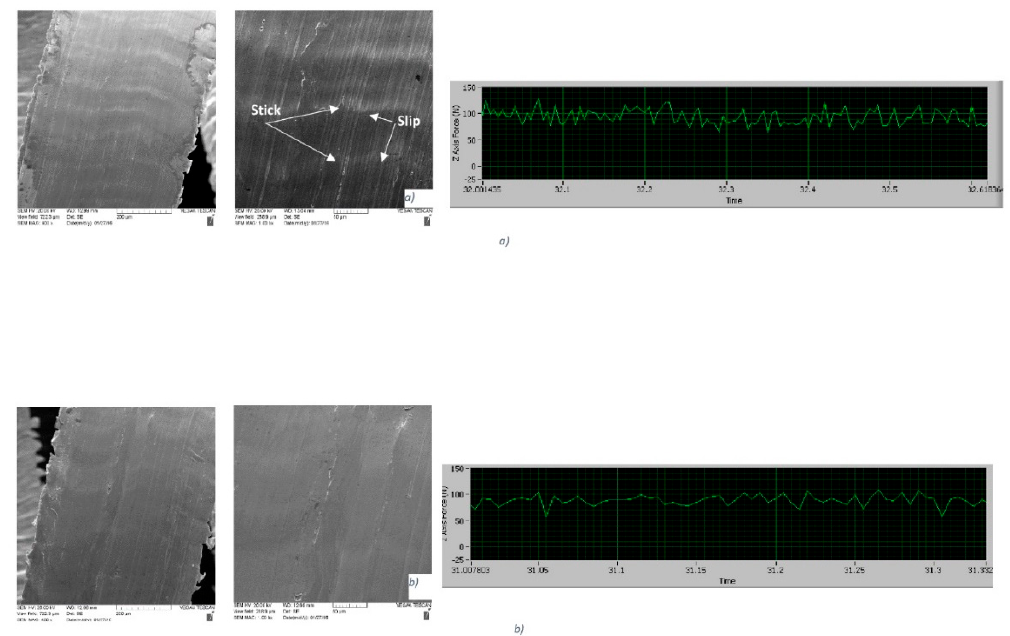
Figure 7. Chip undersurface at different magnifications (400× and 1000×) and cutting forces data: ( a ) uncoated tool; a ( b ) tool with a TiAl60CrSiYN/TiAlCrN multilayer coating, with optimized machining conditions. Reproduced from [31].